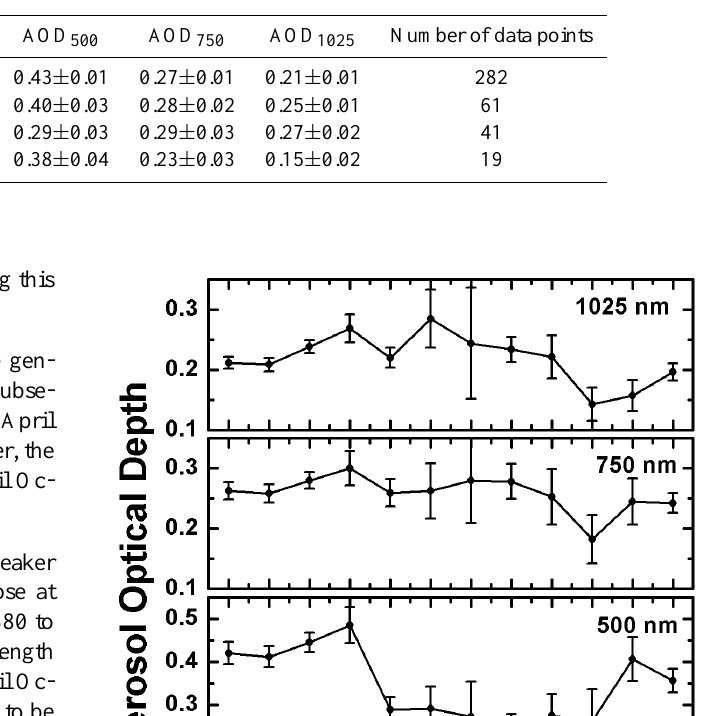
Table 2. Mean AOD at 380, 500, 750 and 1025nm for different seasons.